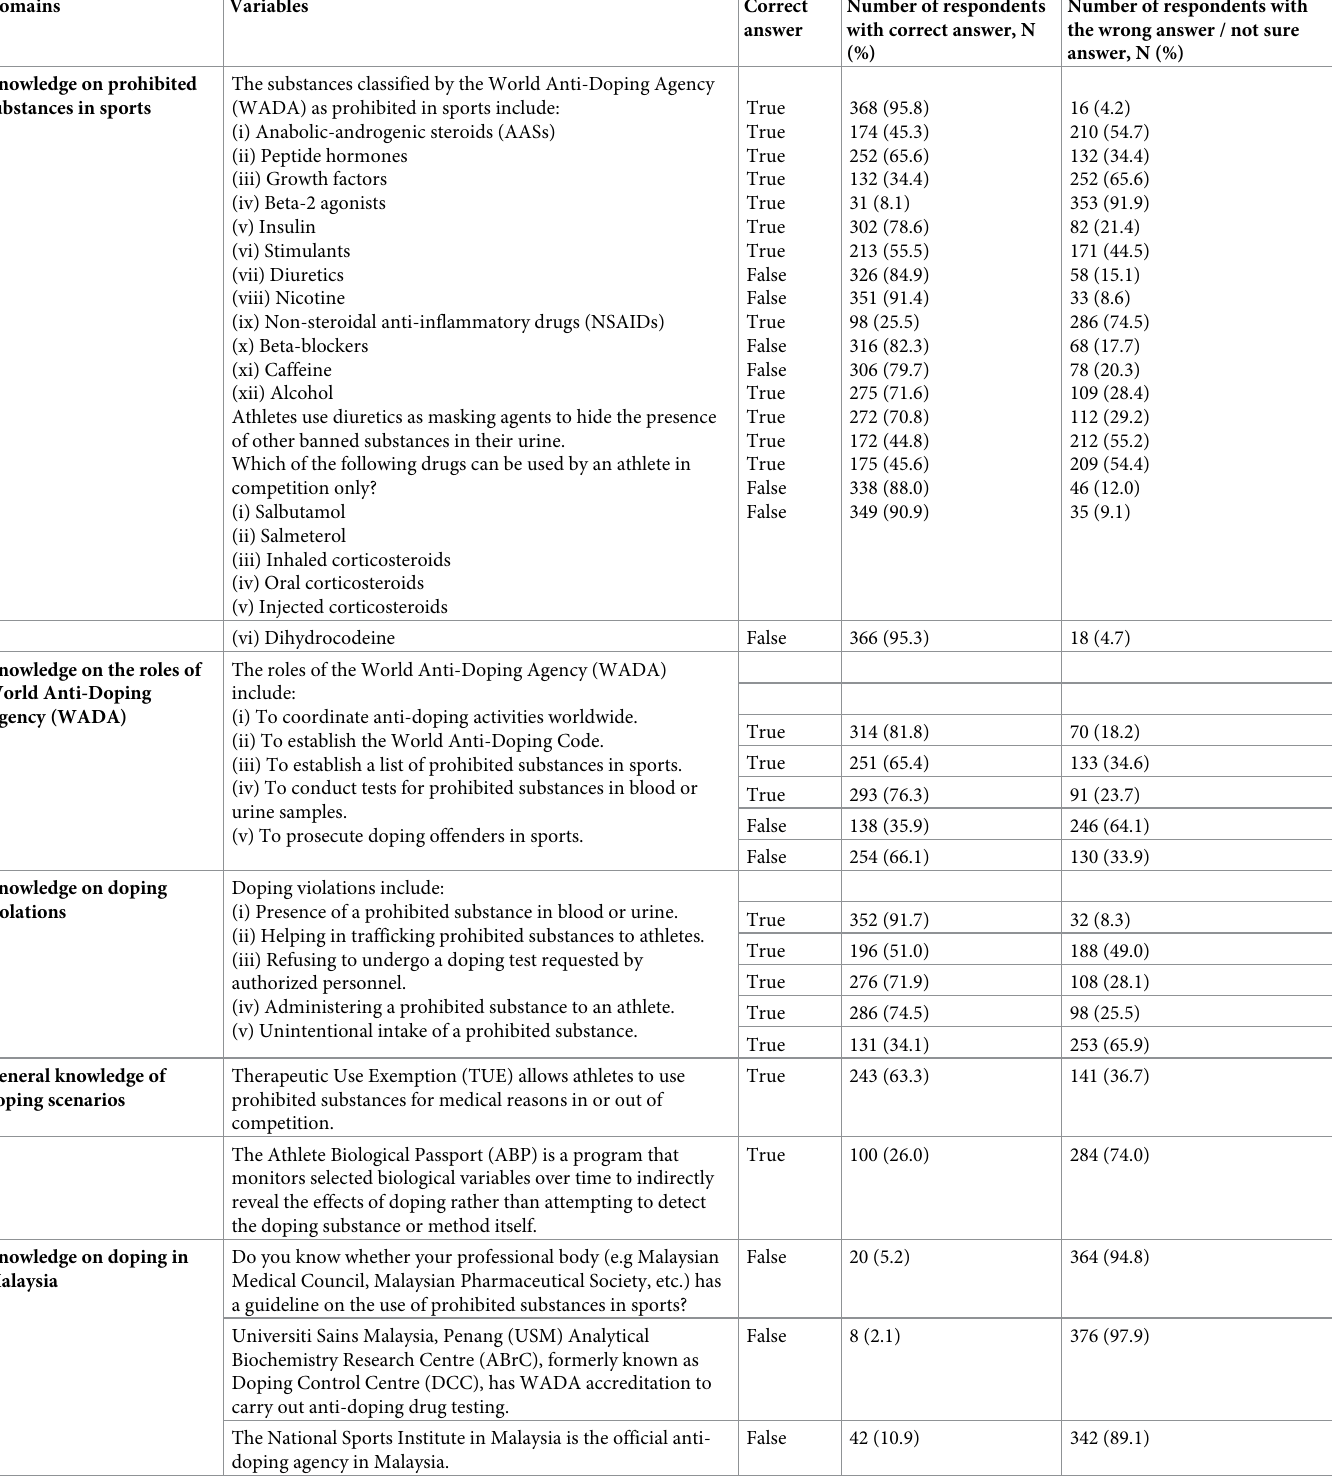
Table 2. The respondents’ knowledge of doping in sports (N = 384).